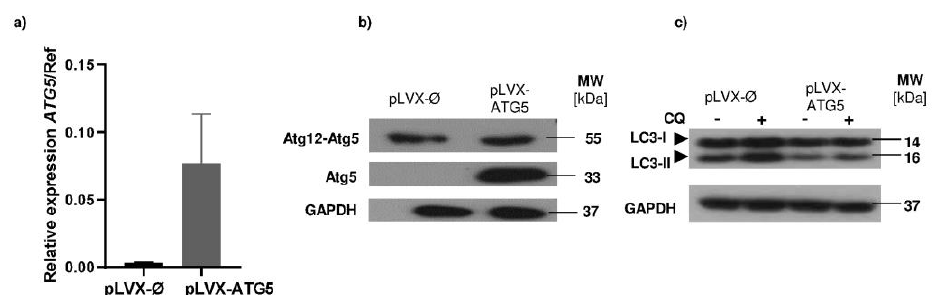
Figure 1. ATG5 overexpression in HL-60 cells does not result in the upregulation of autophagy. (a) HL-60 cells stably transduced with vector containing human ATG5 sequence (pLVX-IRES-Puro- ATG5) and control vector (pLVX-Ires-Puro-Ø , mock control) were collected and total RNA was isolated and reverse transcribed into cDNA. qPCR with LightCycler 480 SYBRGreen I Master kit was performed to determine the mRNA level of ATG5 vs reference genes (β-actin ( ACTB ) and hypoxanthine–guanine phosphoribosyltransferase ( HPRT )) in stably transduced HL-60 cell lines. (b) ATG5 overexpression in stable HL-60-ATG5 and mock control cell lines was confirmed by Western blotting. The band at 53 kD corresponds to the ATG12-ATG5 conjugate and the 33 kDa band corresponds to the unbound ATG5 form. (c) The HL-60 cells were incubated with 50 µM CQ (chloroquine) for 16 h and the level of accumulated LC3-II protein was evaluated by western blotting. MW—molecular weight, GAPDH—glyceraldehyde 3-phosphate dehydrogenase—served as a loading control. ( b , c ) Representative results are shown for one out of four independent experiments.